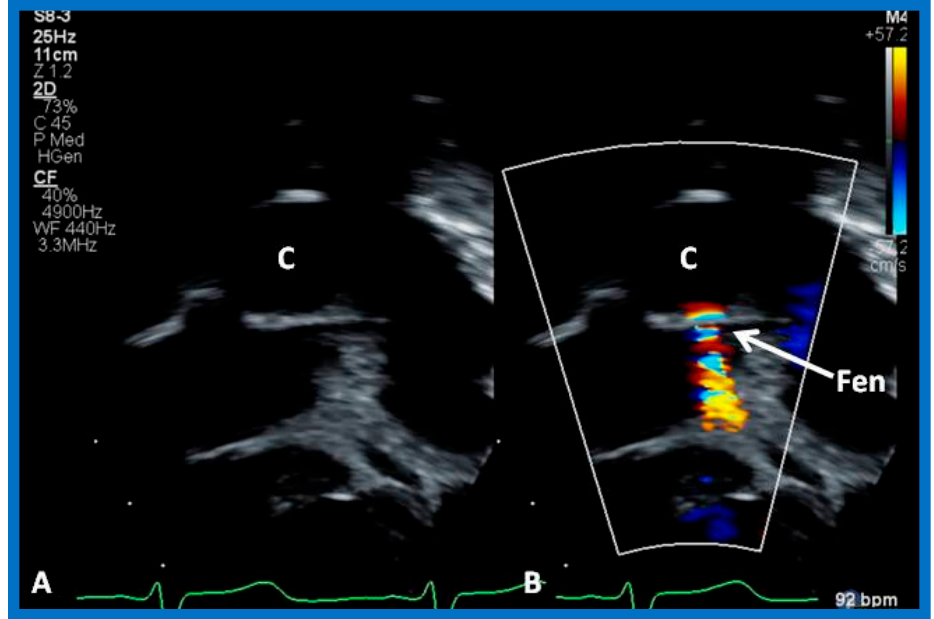
Figure 9. Echo–Doppler recordings in an apical four-chamber view by two-dimensional ( A ) and color Doppler ( B ) illustrating a cross-sectional view of the conduit (C) as shown in ( A ) and the fenestration (Fen) as demonstrated in ( B ). Turbulent flow is seen through the fenestration. Reproduced from [21].